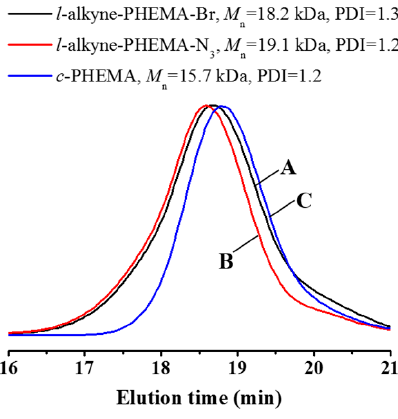
Figure 1. SEC elution traces of l -alkyne-PHEMA–Br (A); l -alkyne-PHEMA–N 3 (B) and c -PHEMA (C) using DMF as the eluent.